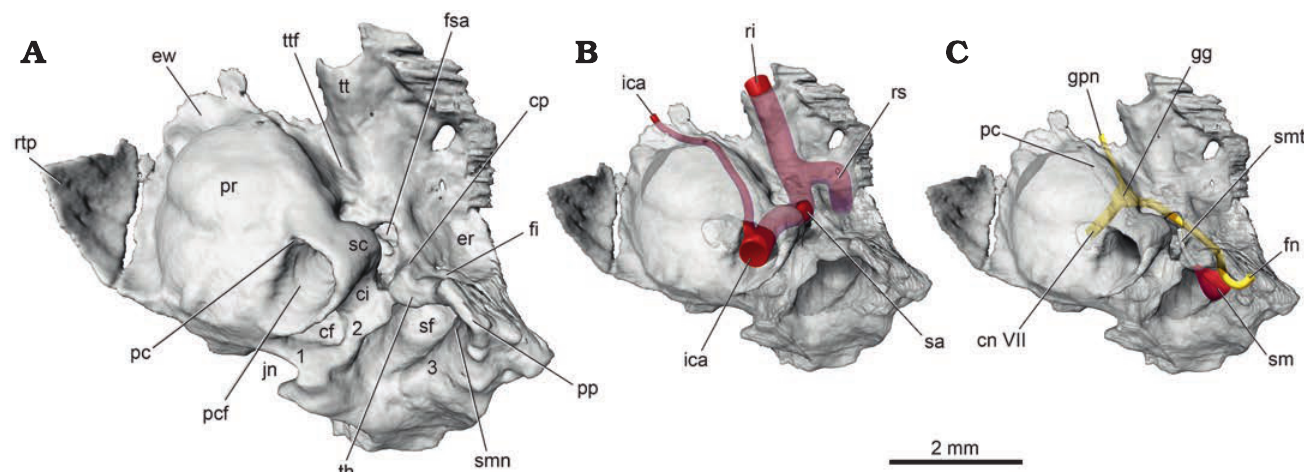
Fig. 2. Palaeoryctid mammal Eoryctes melanus Thewissen and Gingerich, 1989, UM 68074 (UM locality SC-133, Clarks Fork Basin, Wyoming, USA; early Wasatchian Land-Mammal Age, early Eocene), isosurface of left petrosal rendered from CT scans in ventral view. A . Solid petrosal, medial sec- tion of caudal tympanic process (1), lateral section of caudal tympanic process, medial and lateral to stapedius fossa (1, 3, respectively). B . Transparent petrosal with internal carotid artery system (in red). C . Transparent petrosal with facial nerve (in yellow) and stapedius muscle and its tendon (in red and white, respectively). Neurovascular structures redrawn from Avizo segmentation. Abbreviations: cf, cochlear fossula; ci, crista interfenestralis; cn VII, cranial nerve VII; cp, crista parotica; er, epitympanic recess; ew, epitympanic wing; fi, fossa incudis; fn, facial nerve; fsa, foramen for stapedial artery; gg, geniculate ganglion; gpn, greater petrosal nerve; ica, internal carotid artery; jn, jugular notch; pc, promontory canal; pcf, posterior carotid foramen; pp, paroccipital process; pr, promontorium; ri, ramus inferior; rs, ramus superior; rtp, rostral tympanic process; sc, stapedial canal; sf, stapedius fossa; sm, stapedius muscle; smn, stylomastoid notch; smt, stapedius muscle tendon; th, tympanohyal; tt, tegmen tympani; ttf, tensor tympani